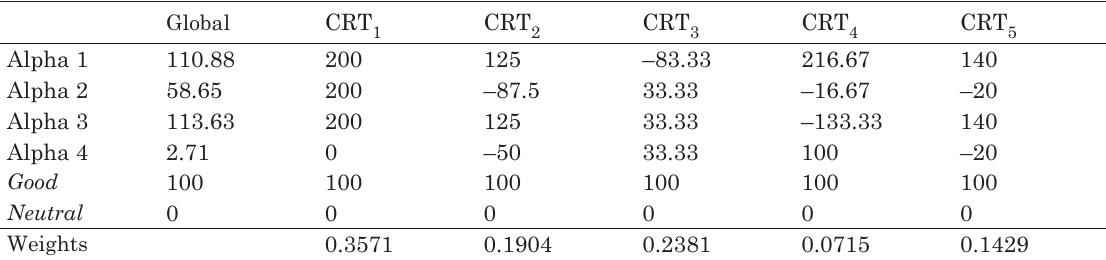
Table 3. Partial values and overall attractiveness revealed by the four branches